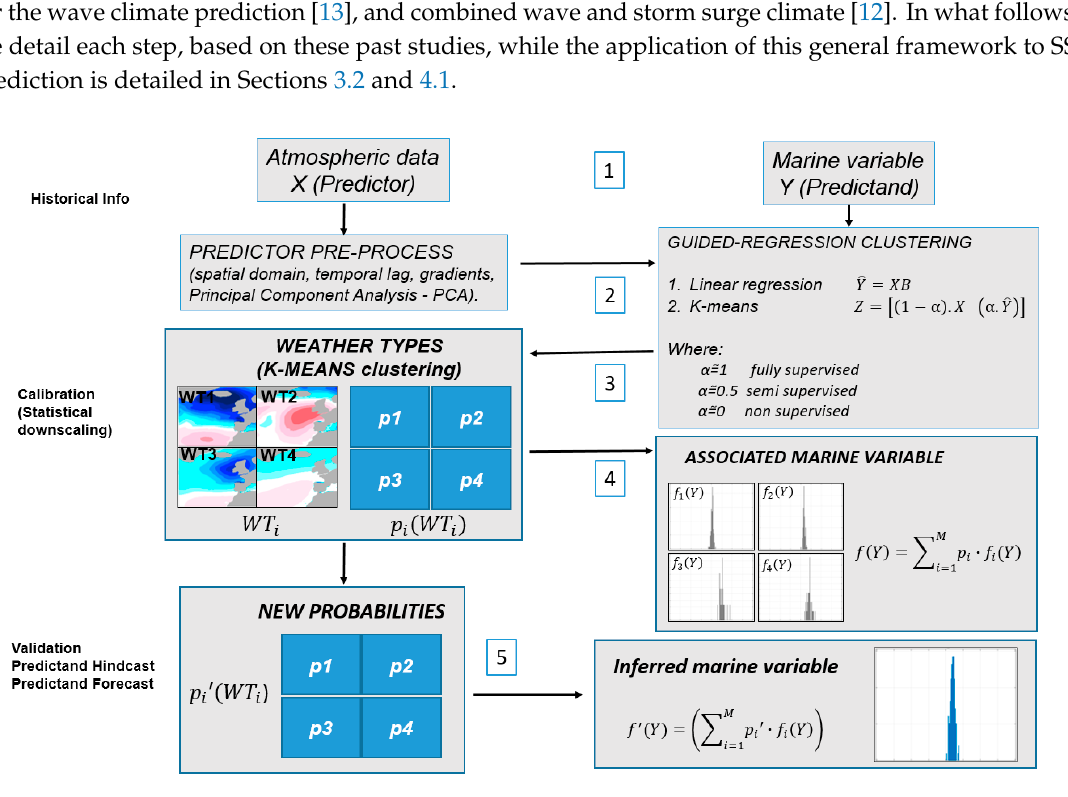
Figure 3. General chart flow of WT-based statistical downscaling approach. The numbers (1 to 5) indicate the main steps of the method. The p and p ’ are the probabilities of each weather type (WT) during the calibration and validation periods, respectively. The f(Y) and f’(Y) are the probability density functions of the predictand in the calibration and validation period, respectively.